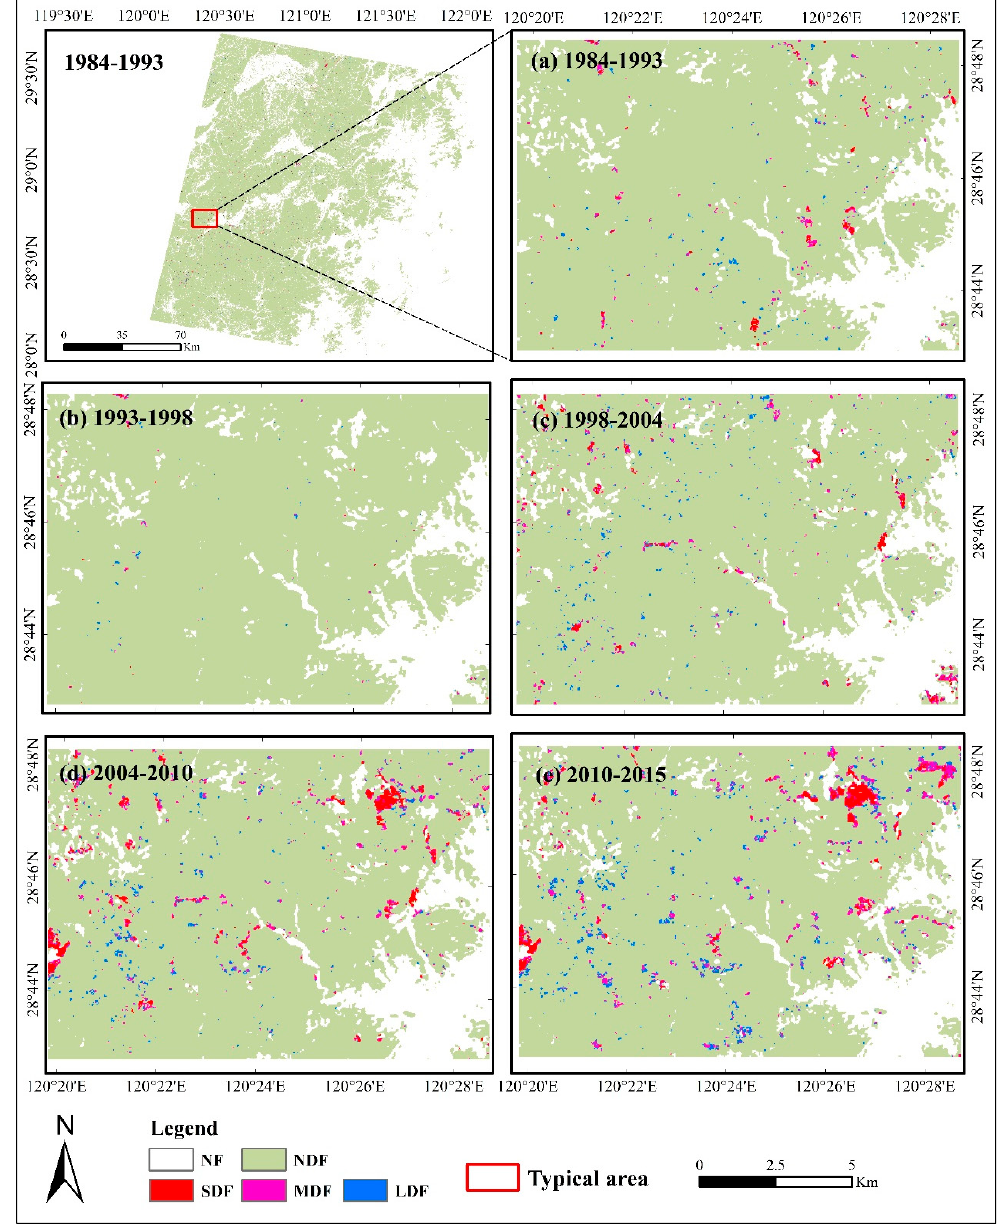
Figure 2. Comparison of spatial patterns of forest disturbance among detection periods. ( a ) 1987–1993; ( b ) 1993–1998; ( c ) 1998–2004; ( d ) 2004–2010; ( e ) 2010–2015; NF, no forest; NDF, no disturbance forest; SDF, serious disturbance forest; MDF, moderate disturbance forest; LDF, light disturbance forest.